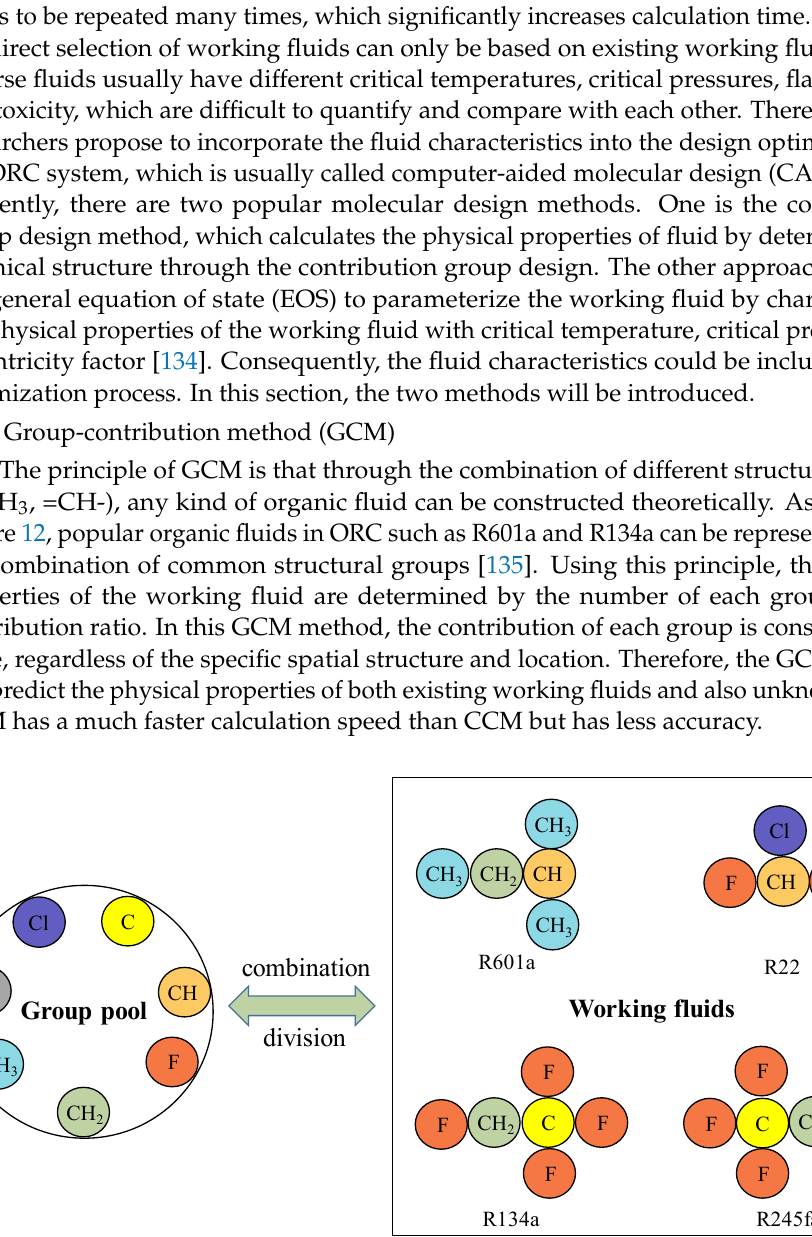
Figure 12. Diagram of the group-contribution method (GCM).